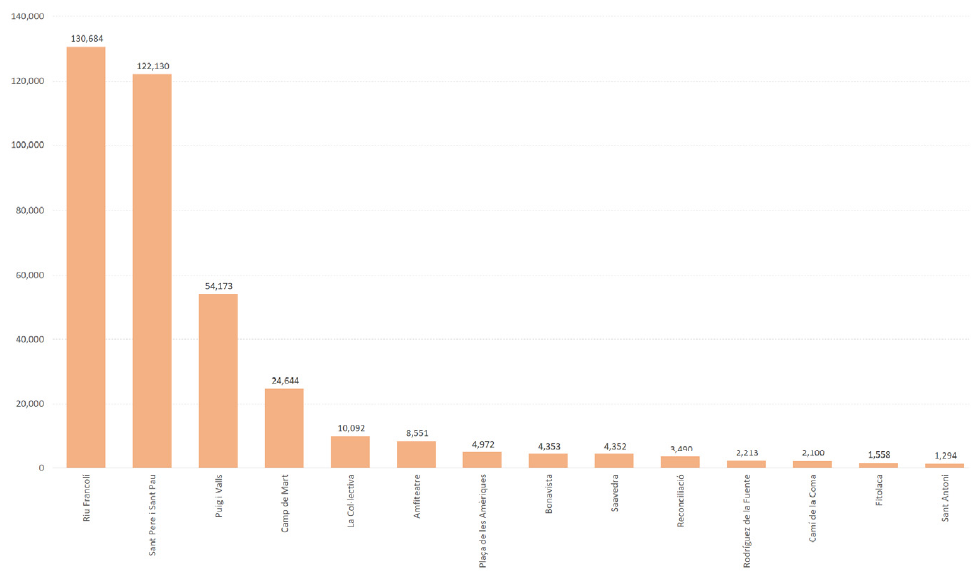
Table 2. Average surface area available per inhabitant and average distance to the nearest urban park.